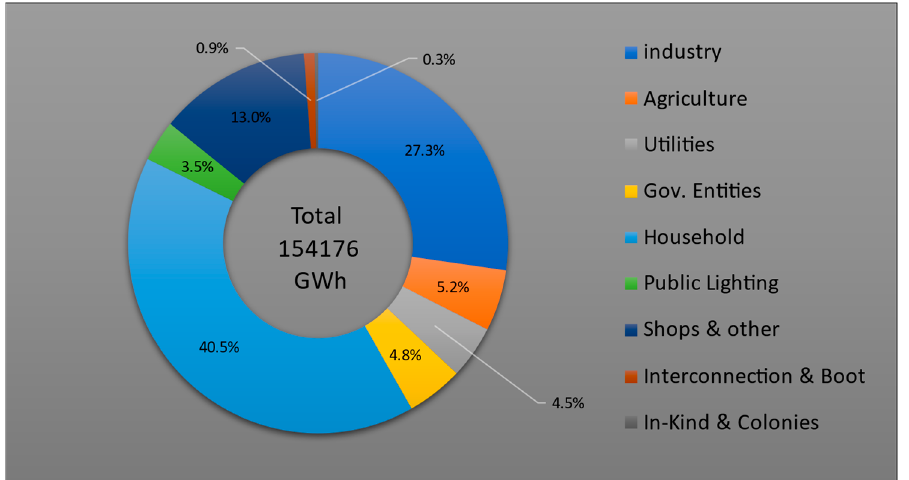
Figure 1. Electricity consumption in Egypt classified by usage